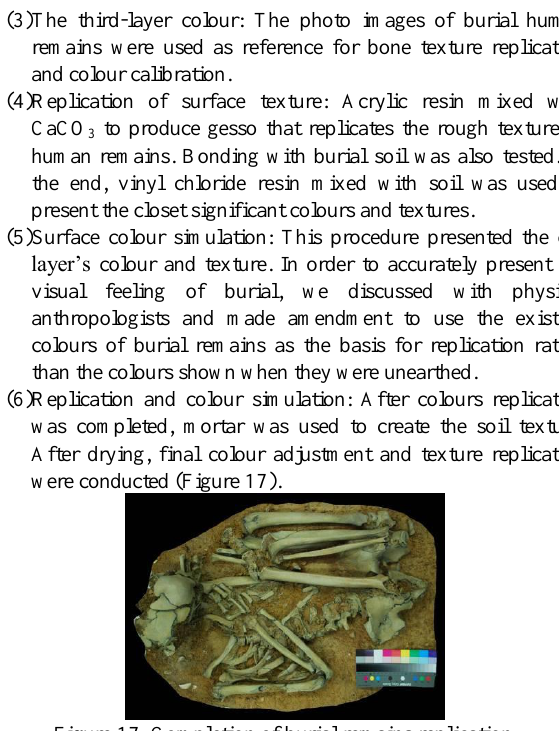
Figure 16.The second-layer colour.